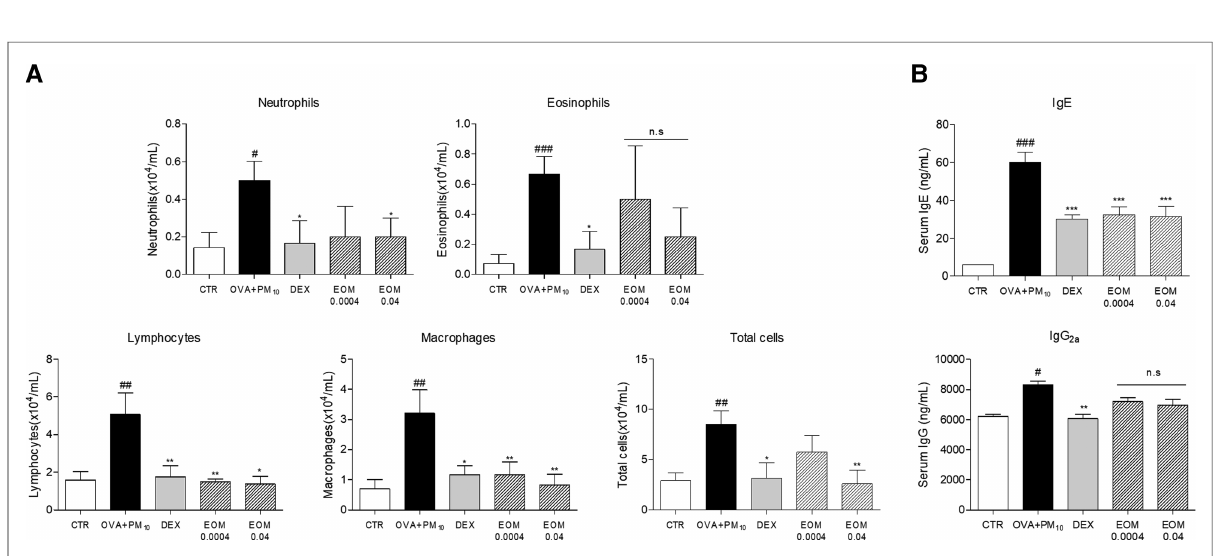
FIGURE 4 Effects of EOM on the in fi ltration of in fl ammatory cells and IgE production in the NALF. The in fl ammatory cells were counted by hemocytometer ( A ). EOM (0.0004, 0.04% v/v orally) was given to OVA and PM10-induced allergic rhinitis. The IgE and IgG2a were evaluated by ELISA ( B ). EOM (0.0004, 0.04% v/v orally) was given to OVA and PM10-induced allergic rhinitis. Results are presented as mean±standard error of the mean. ### p <0.001 vs. CTR group; * p <0.05, ** p <0.01 and *** p <0.001 vs. OVA and PM10-treated group. CTR, control; EOM, essential oils from the Mentha piperita leaf ; OVA, ovalbumin; NALF, nasal lavage fl uid; ELISA, enzyme-linked immunosorbent